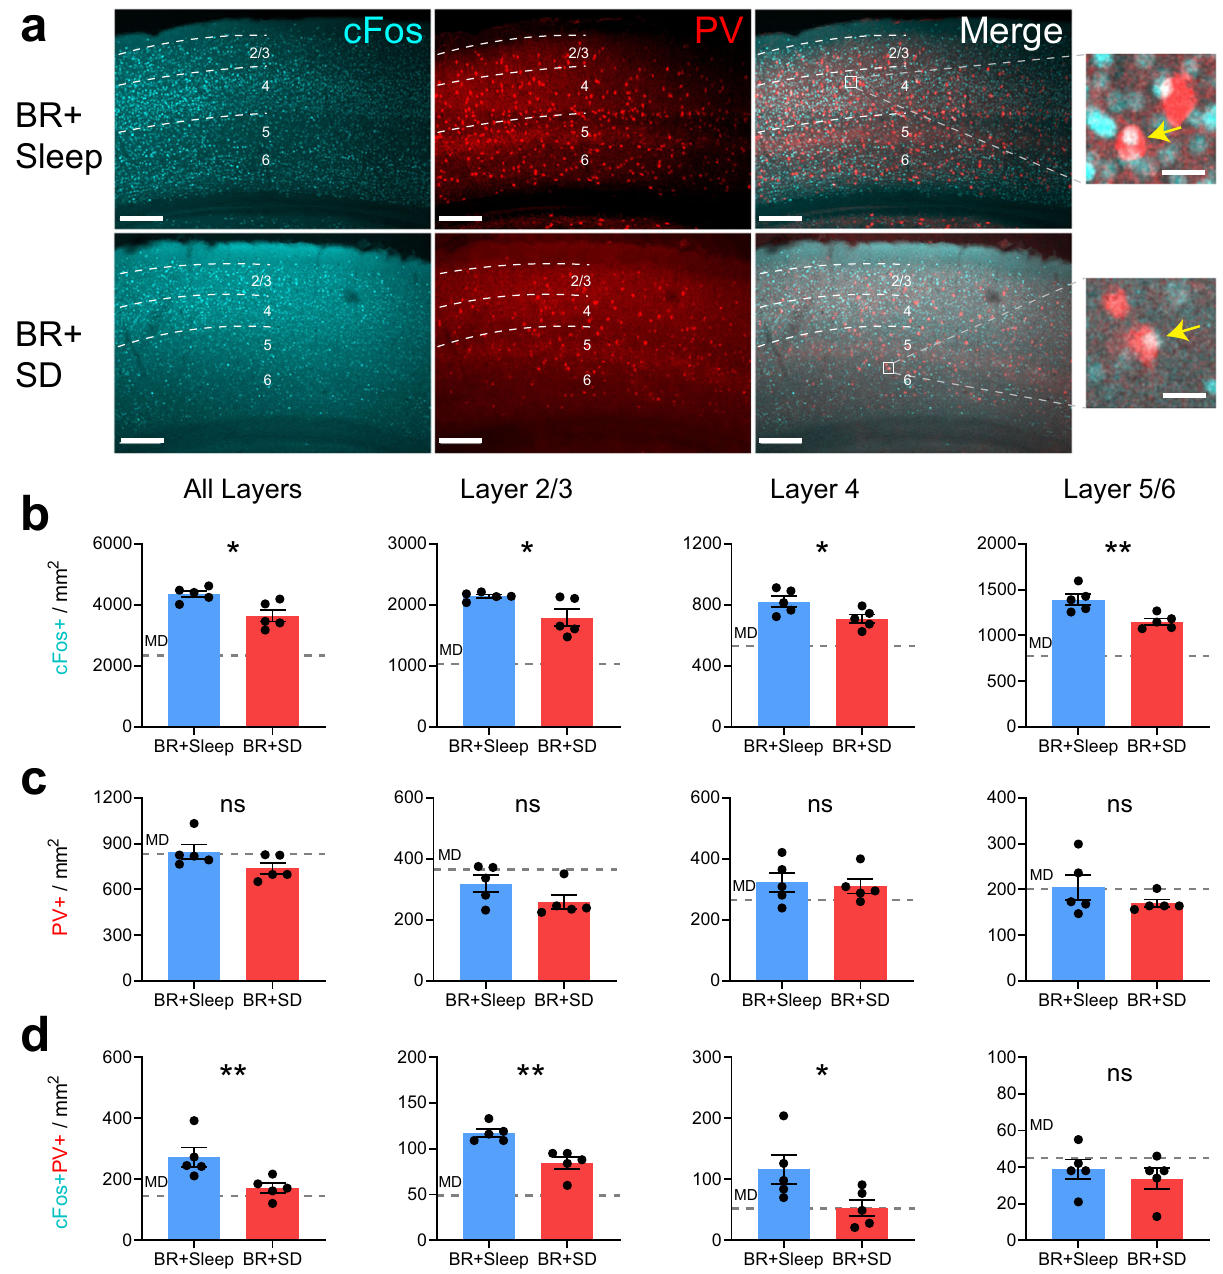
Fig. 6 Post-BR SD prevents recovery of DE-driven cFos expression in bV1. a bV1 cFos (cyan) and PV (red) expression after DE stimulation in BR + Sleep and BR + SD mice. Mice ( n = 5/treatment group) received DE-only visual stimulation for 30 min, then were returned to their home cages for 90 min prior to perfusion. Scale bar = 100 µ m; 20 µ m (magni fi cation inset). b DE-driven cFos + neuron density was reduced in BR + SD mice relative to BR + Sleep mice. Unpaired t -test: p = 0.013. cFos + neuron density was reduced in bV1 layers 2/3, 4, and 5/6 after BR + SD relative to BR + Sleep. Unpaired t-test for layers 2/3, 4, or 5/6, respectively: p = 0.036, p = 0.041, and p = 0.008. c PV immunostaining was similar between groups. PV + interneuron density in